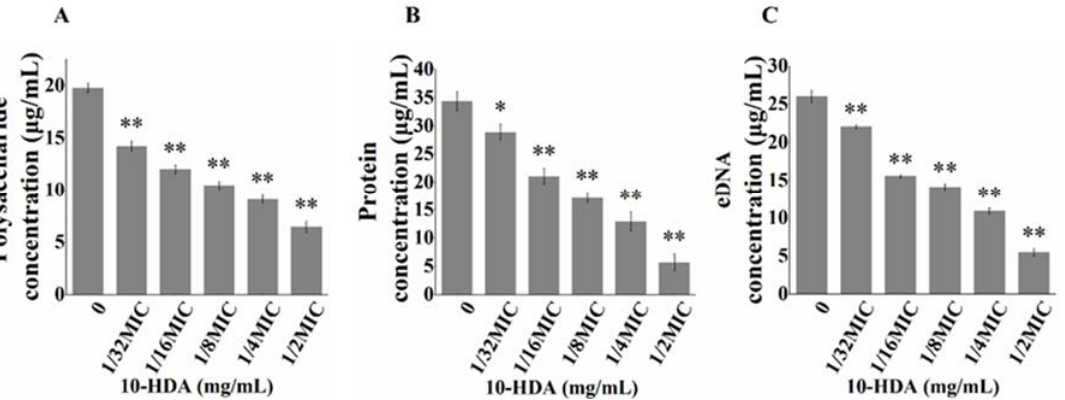
Figure 4. The contents of extracellular ( A ) polysaccharides, ( B ) proteins, and ( C ) eDNA in S. aureus biofilms after 10-HDA treatment. * p < 0.05, ** p <